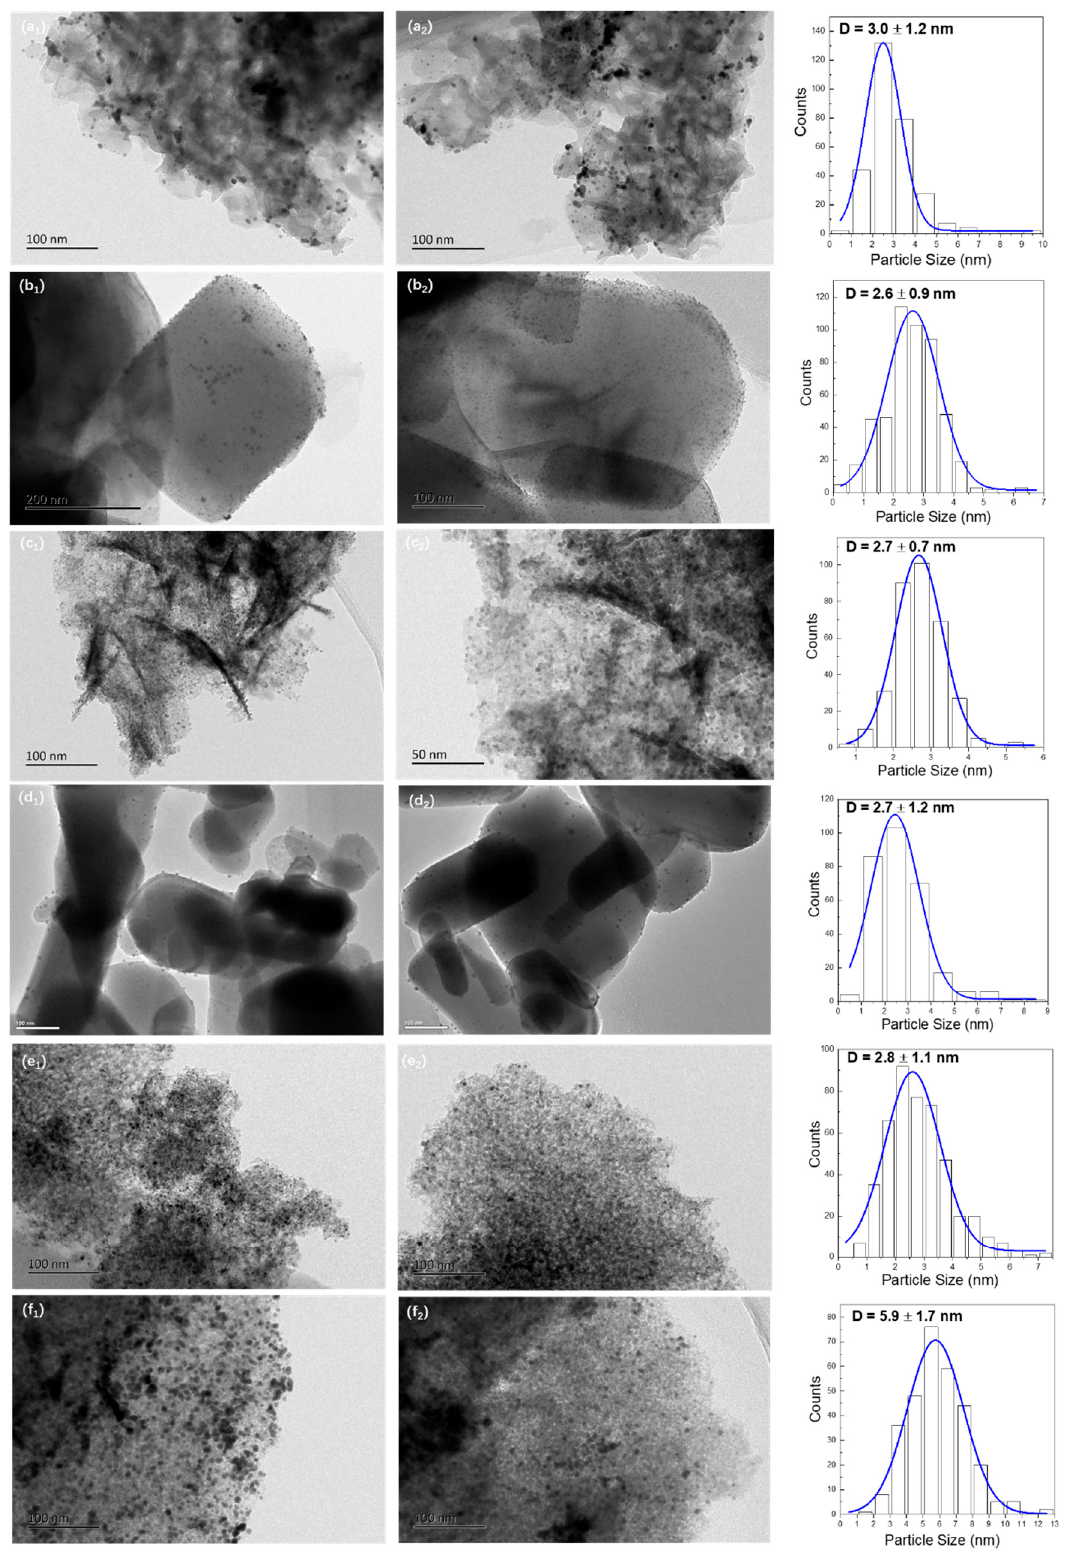
Figure 4. TEM images and size distribution histograms of different supported gold catalysts; ( a 1 – 2 ) Au 25 / MgAl-300; ( b 1 – 2 ) Au 25 / MgO-300; ( c 1 – 2 ) Au 25 / ZnAl-300; ( d 1 – 2 ) Au 25 / ZnO-300; ( e 1 – 2 ) Au 25 / Al 2 O 3 -300; ( f 1 – 2 ) Au 25 / SiO 2 -300.